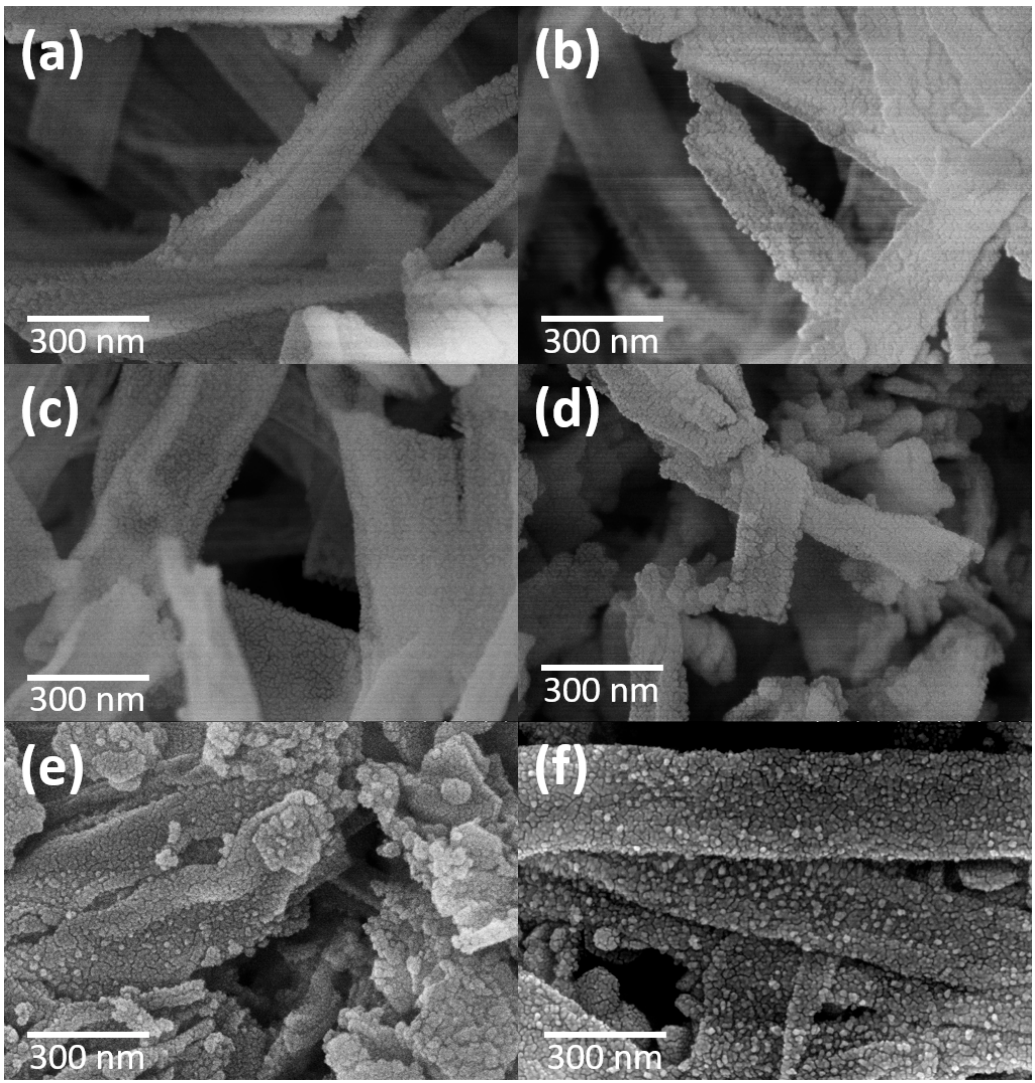
Figure 5. FESEM images of CeO 2 -CuCrO 2 nanofibers after SRM at different temperatures ( a ) 523 K, ( b ) 573 K, ( c ) 623 K, ( d ) 673 K, ( e ) 723 K, and ( f ) 773 K.